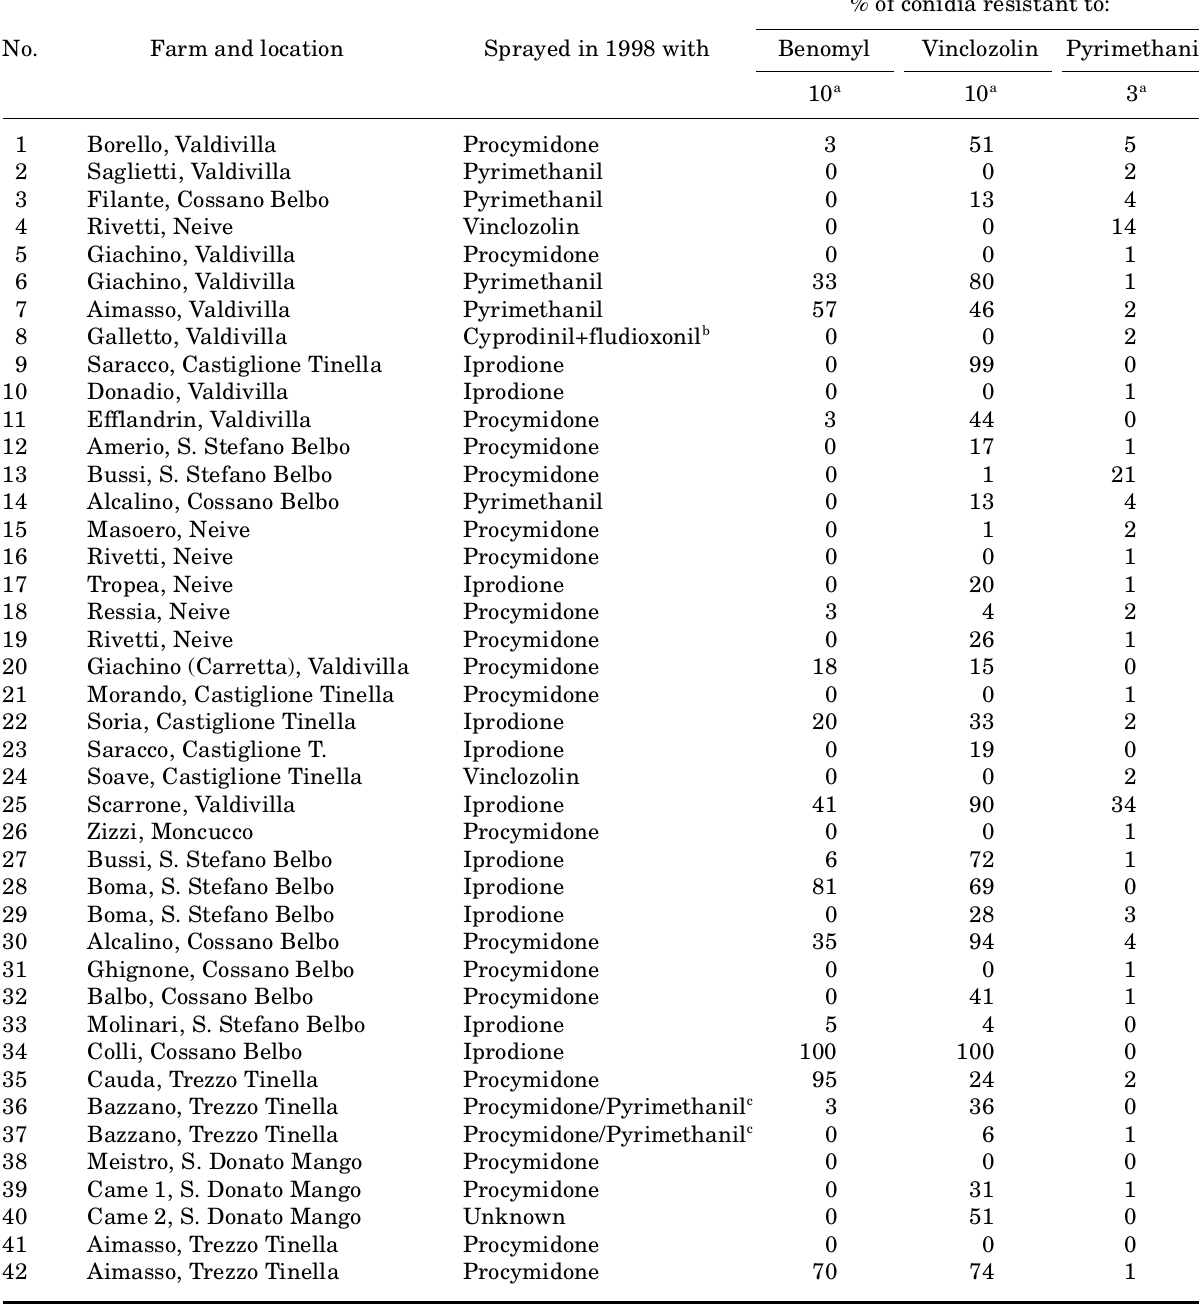
Table 1. Results of a survey in Italian vineyards of the cultivar Moscato in 1998 to detect resistance of Botrytis cinerea populations to different classes of